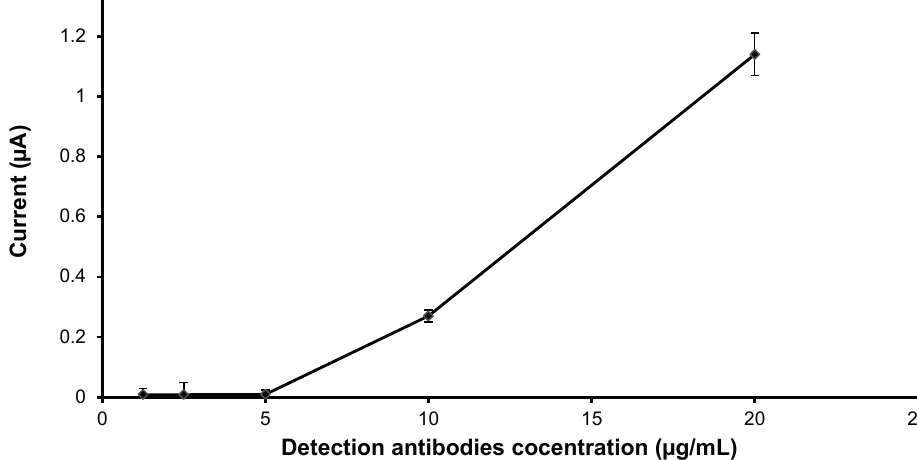
Figure 6. Optimization of detection anti-NS1 antibody concentration.